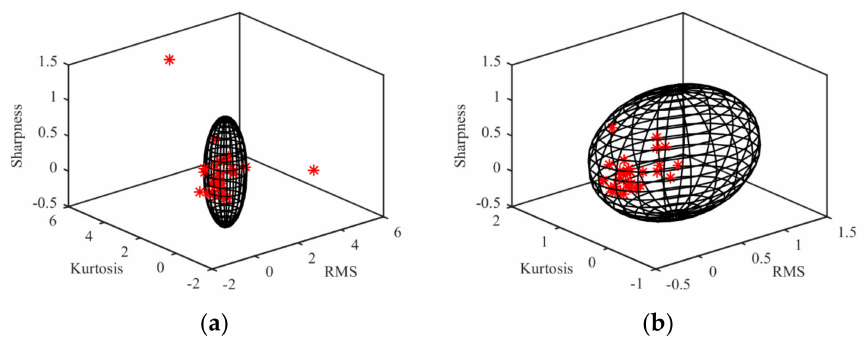
Figure 14. Flywheel #3 test noise sample point and security domain: ( a ) 3000 r / min; ( b ) 4600 r / min.